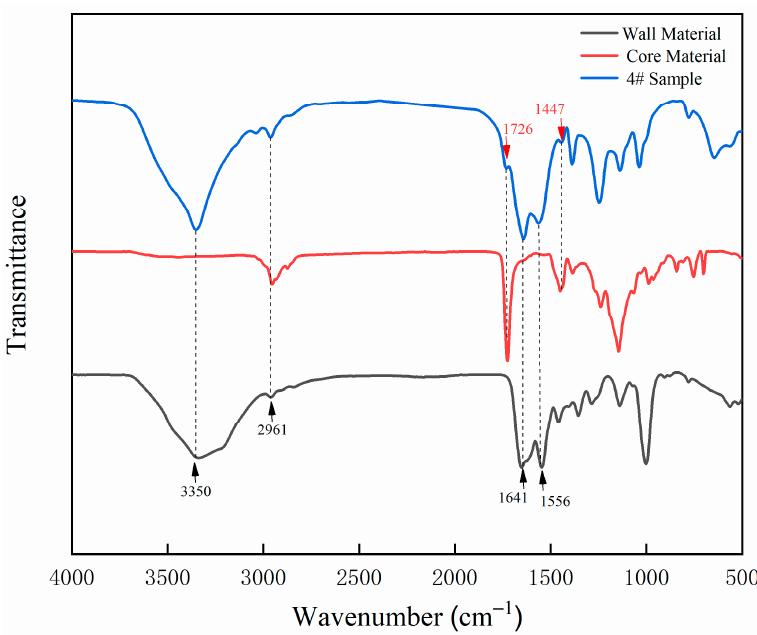
Figure 4. The FTIR spectrogram of wall material, core material, and sample 4# microcapsule.